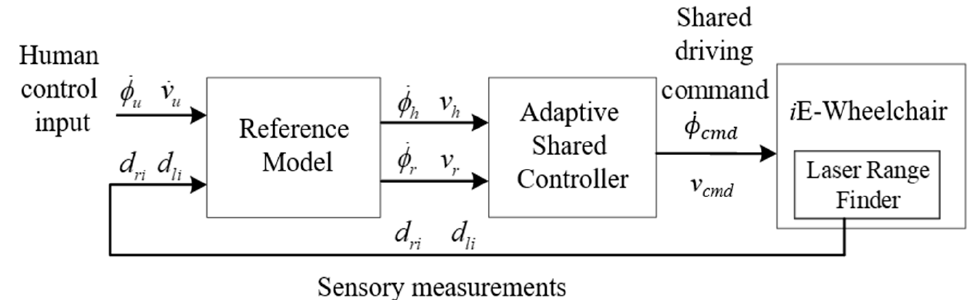
Figure 7. Block diagram of the proposed adaptive shared control system in the i E-Wheelchair.